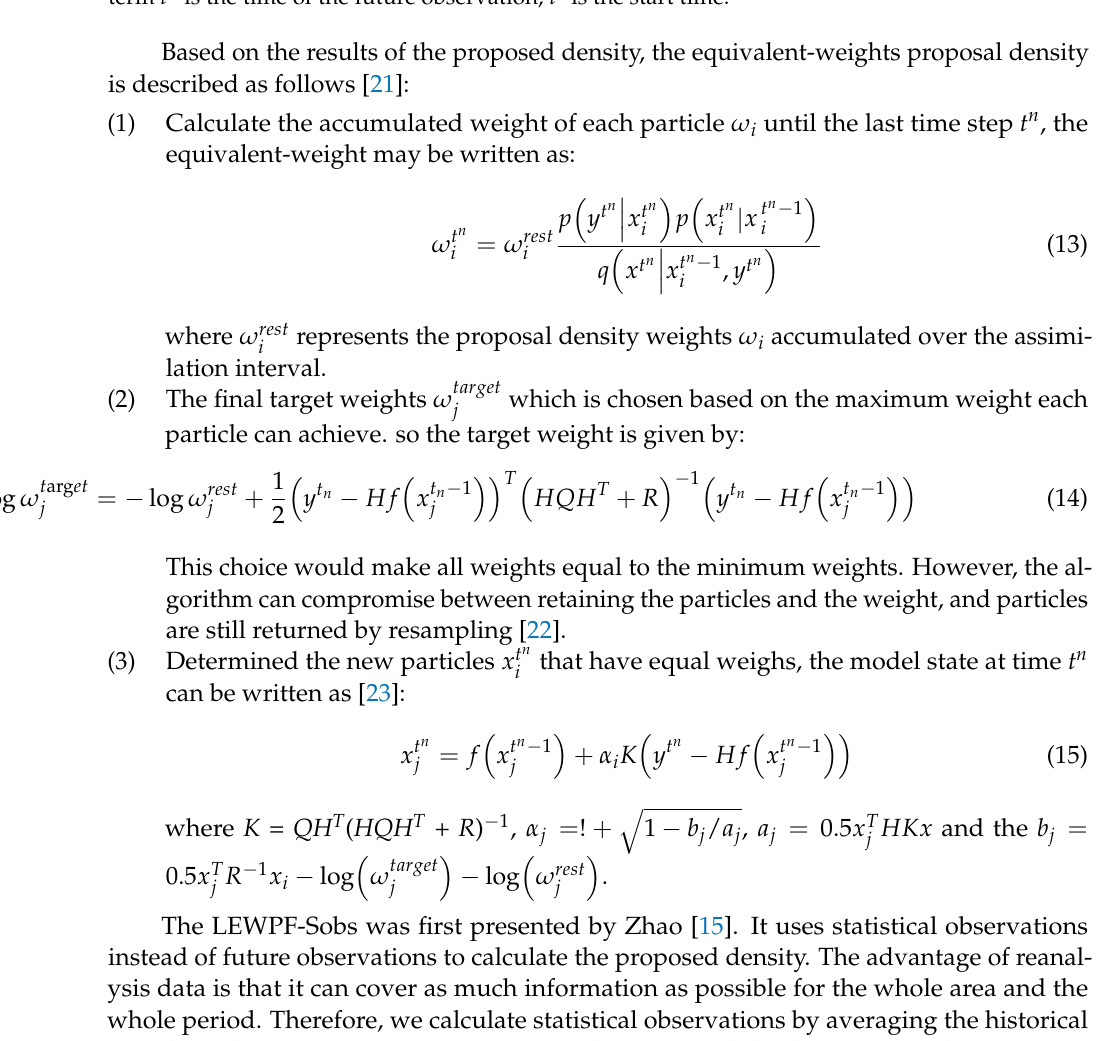
Figure 1. Schematic showing the assimilation interval in terms of the model integration step. The term t n is the time of the future observation, t a is the start